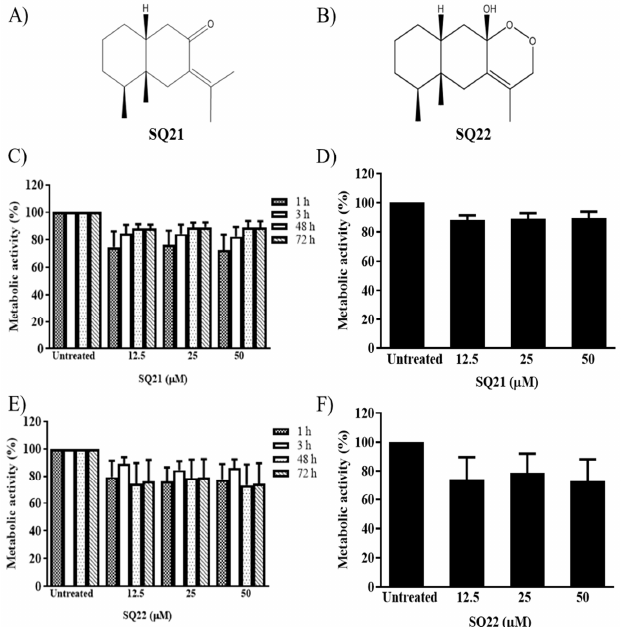
Figure 1. Chemical structure of fukinone (SQ21, ( A )), and 10 β H-8 α , 12-Epidioxyeremophil-7(11)-en-8 β -ol (SQ22, ( B )). Human mast cells (LAD2 cells) were treated with 12.5, 25, or 50 µ M of the bicyclic eremophilane SQ21 ( C , D ), and SQ22 ( E , F ), and cell viability was evaluated 1 to 72 h after treatment, and expressed as percentage of metabolic activity rate with respect to untreated control cells ( n = 3, ± SEM). LAD2 cells treated for 24 h with SQ21 ( D ), or SQ22 ( F ) are shown separately.